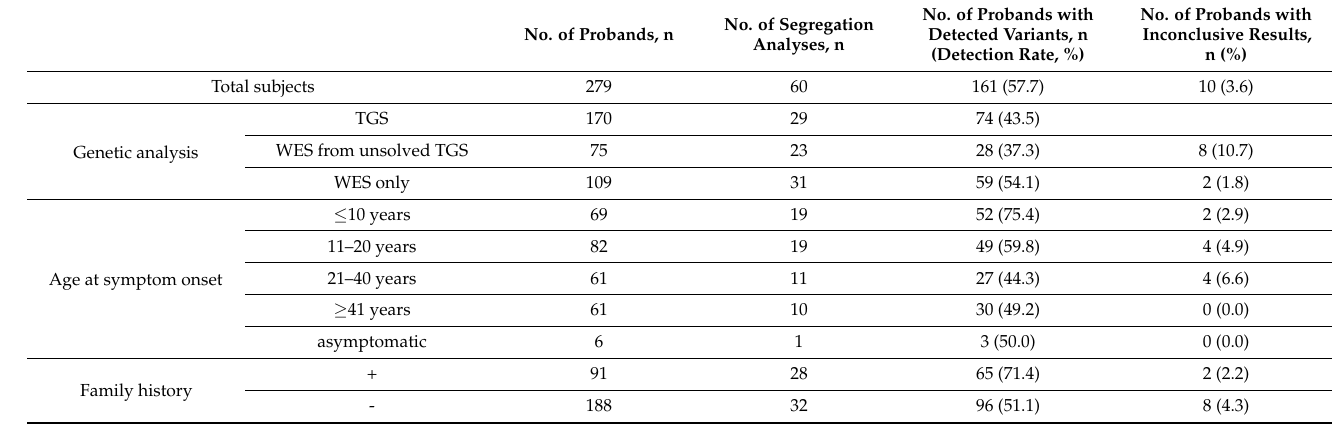
Table 2. Diagnostic yields of the genetic tests in patients with retinitis pigmentosa. No. of Probands,